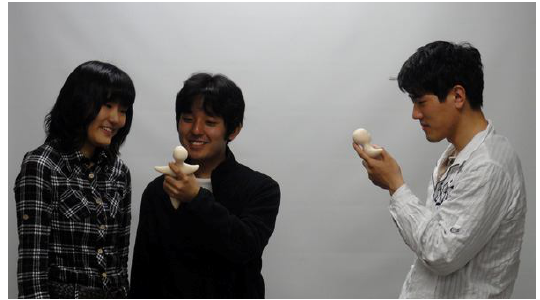
Figure 2. Users hold the Elfoid and make a